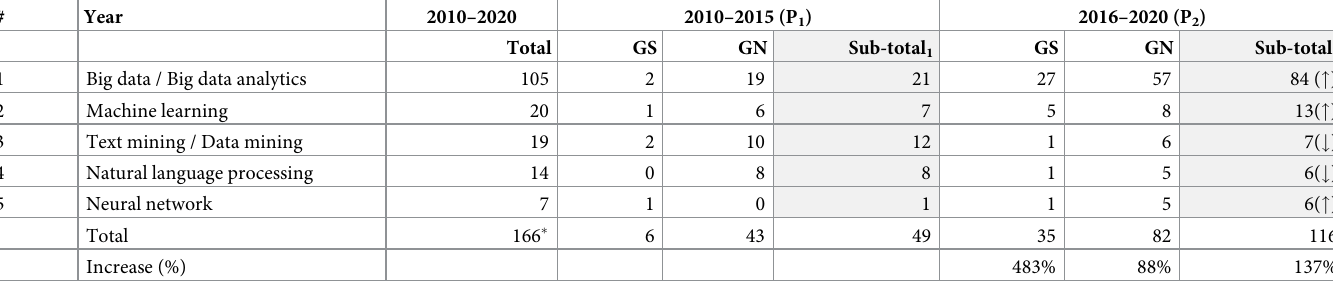
Table 3. Most researched AI-related keywords among Global South and Global North scholars